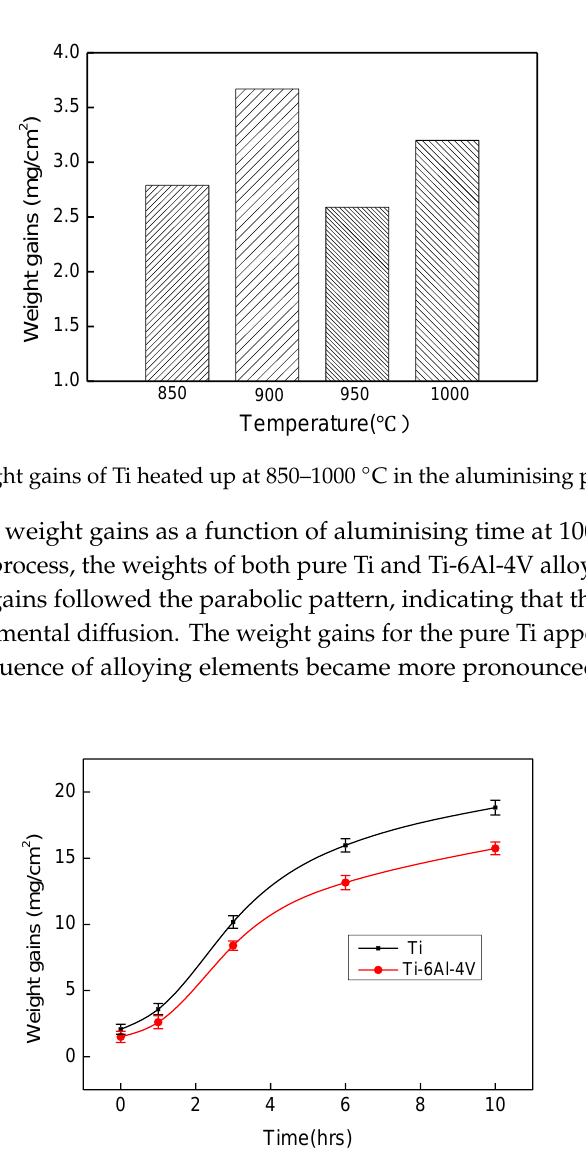
Figure 2. Weight gains of aluminised Ti and Ti-6Al-4V at 1000 °C for up to 10 h.